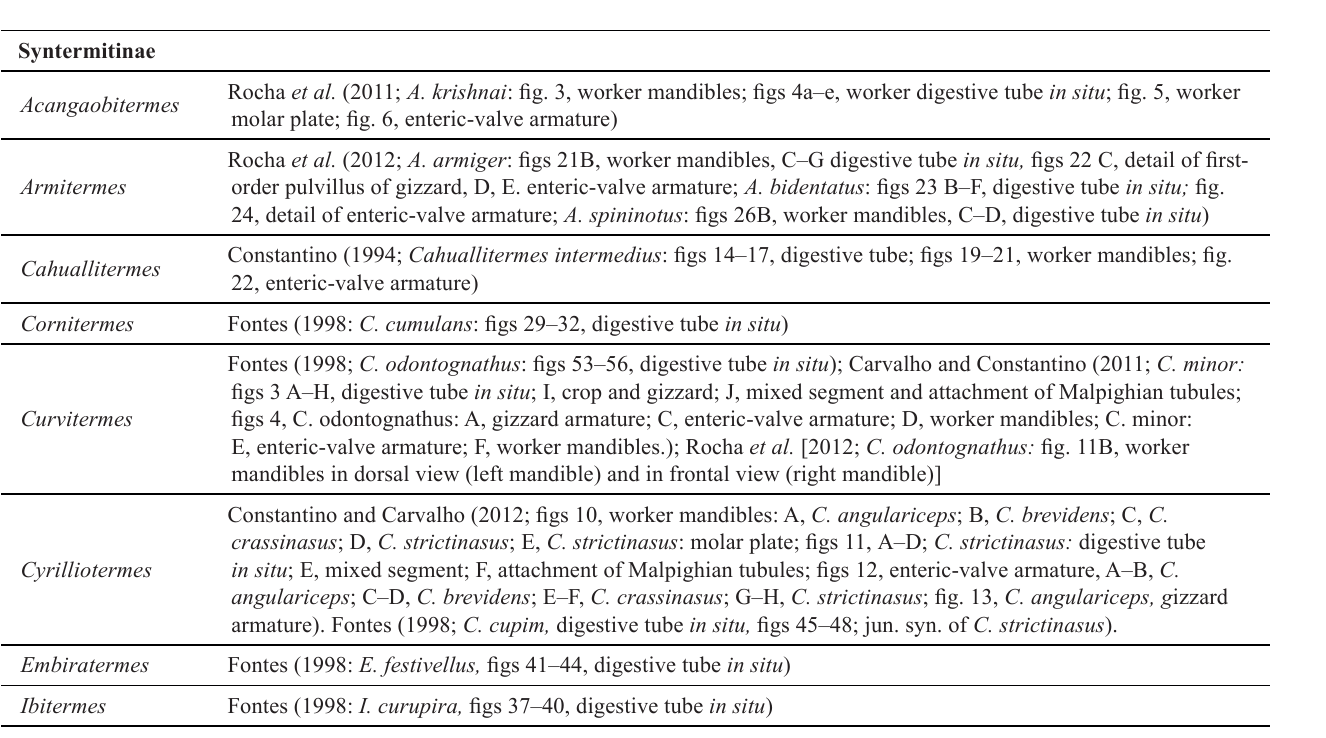
Table 1. List of taxonomic studies that treat the worker caste of Neotropical Termitidae genera.